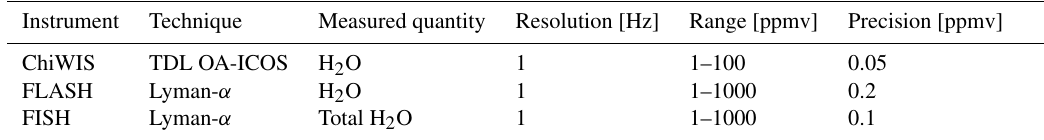
Table 1. Summary of realized instrument performance* measured in UTLS conditions for the three in situ hygrometers. Instrument Technique